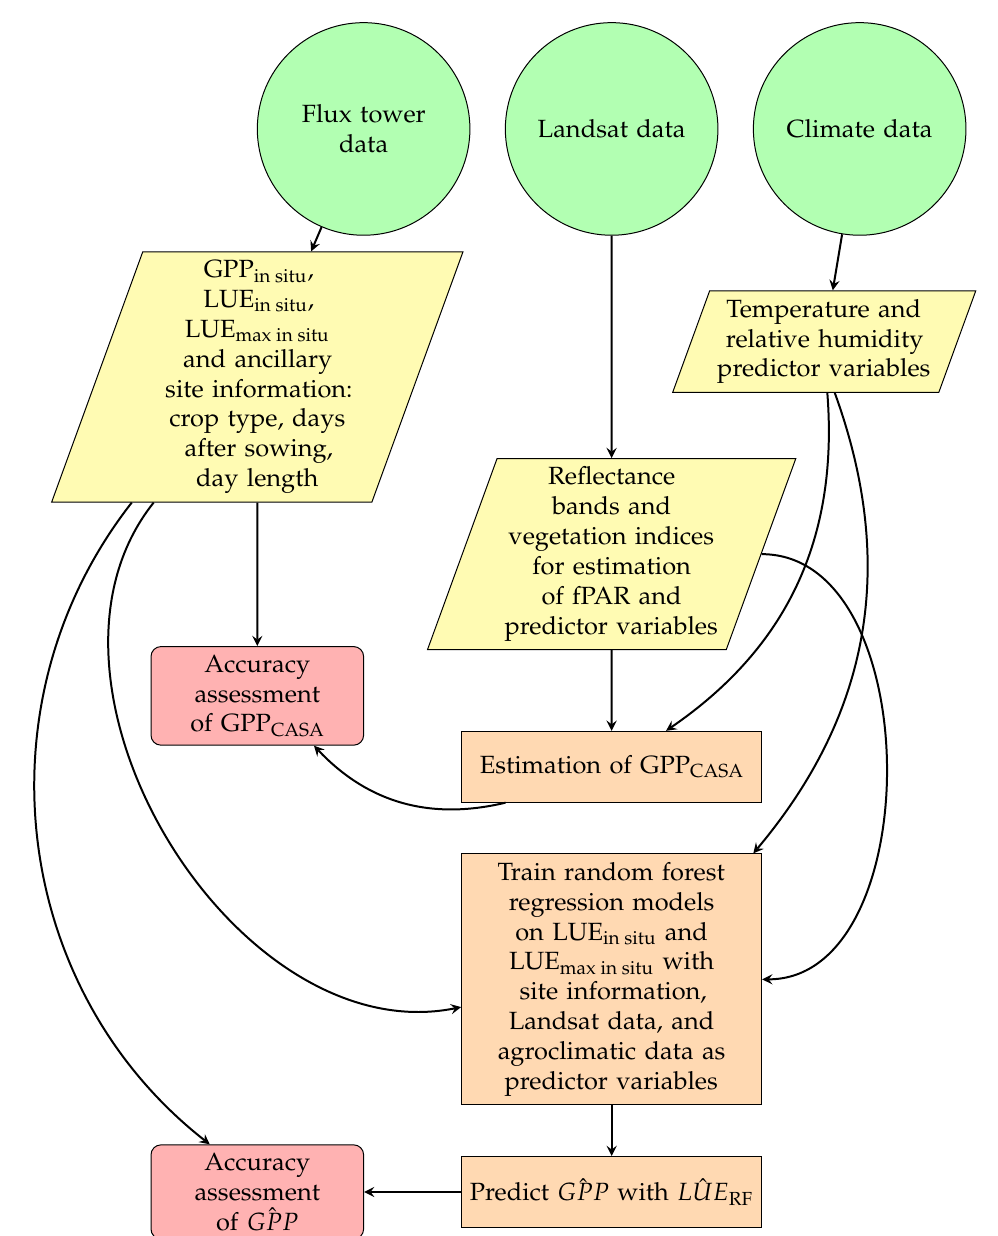
Figure 1. Flowchart of methodology showing data sources (circles), data items (trapezoids), algo- rithms or estimations (rectangles), and accuracy assessments of GPP estimations (rounded